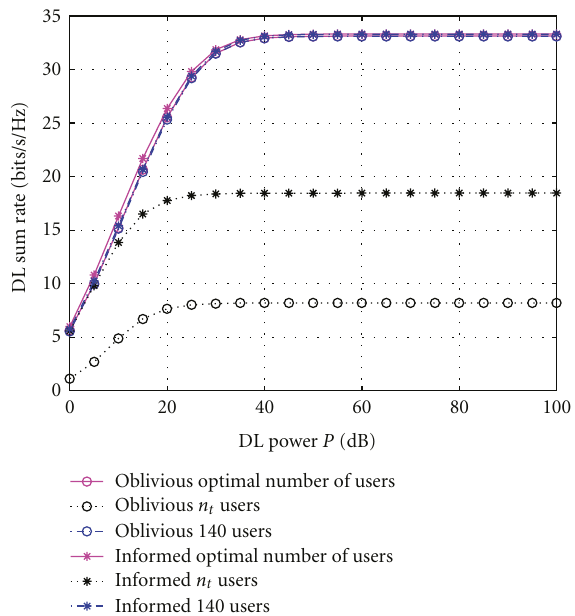
Figure 6: Sum rate with optimal number of users versus DL power P .